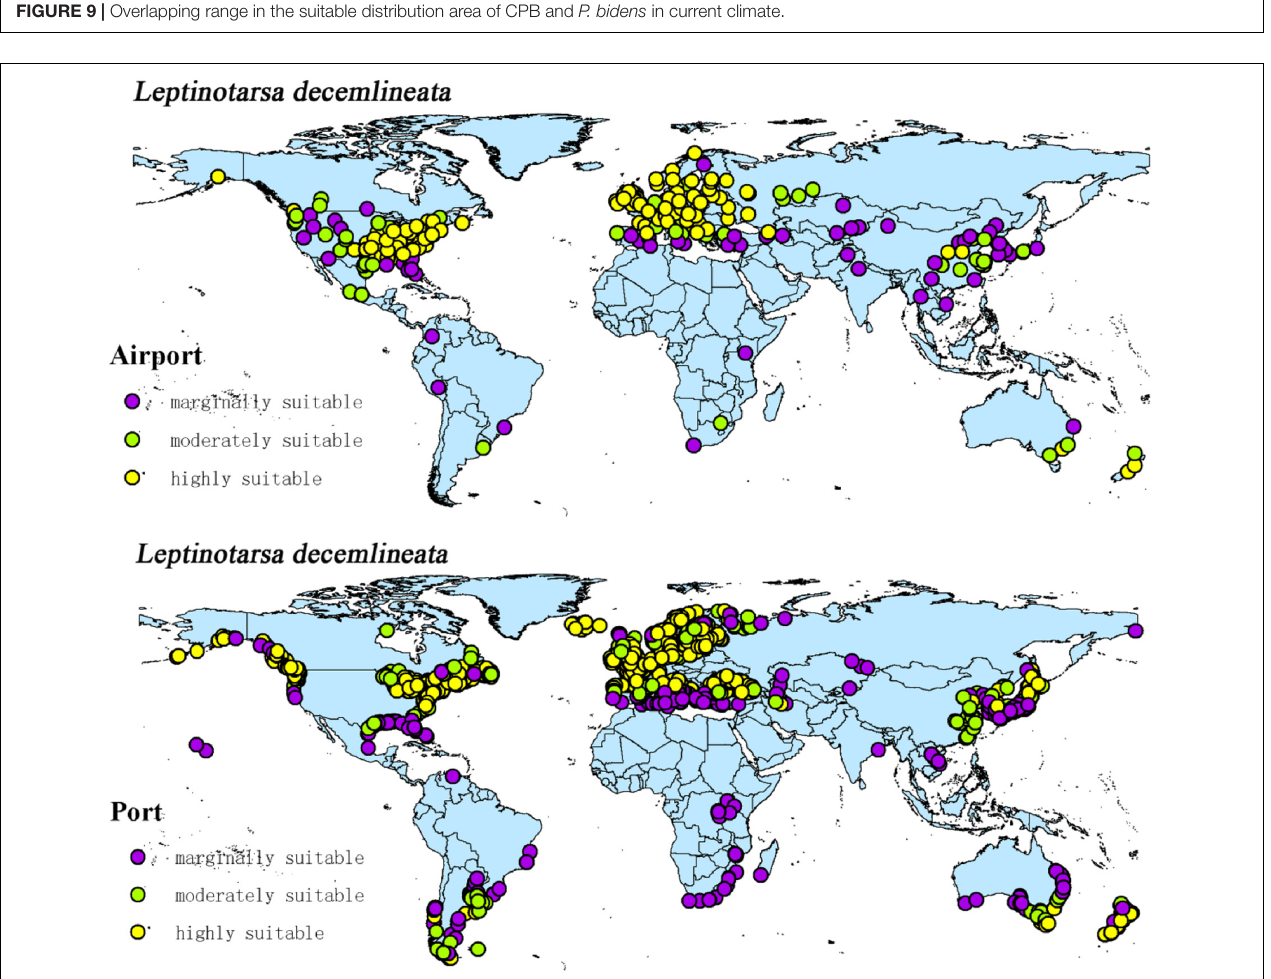
FIGURE 10 | Global large airports and ports within the suitable of